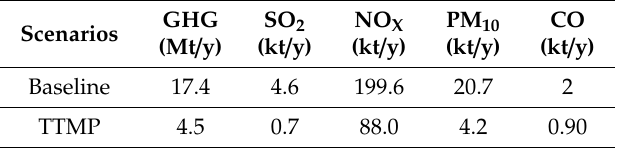
Table 8. Expected GHG emissions and pollutants reductions from the TTMP in 2030.